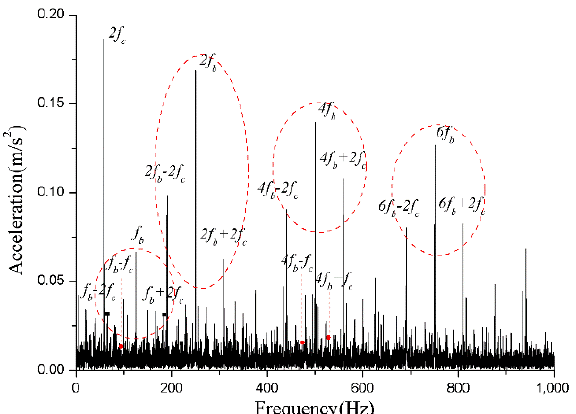
Figure 41. The envelope spectrum of the test signal (severe friction).